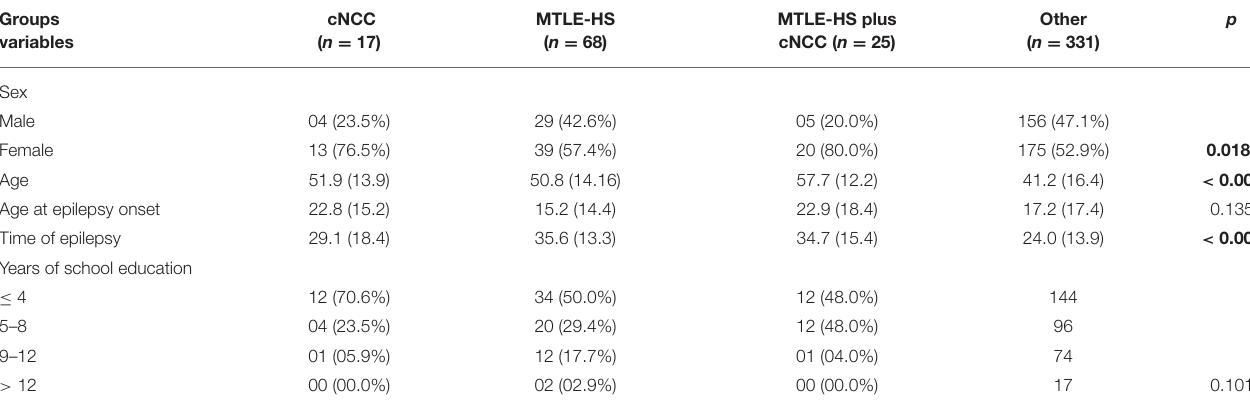
TABLE 5 | MTLE-HS according with the presence or absence of neurocysticercosis.